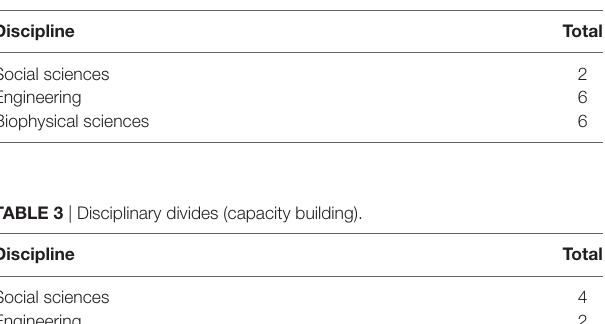
TaBle 2 | Disciplinary divides (purpose